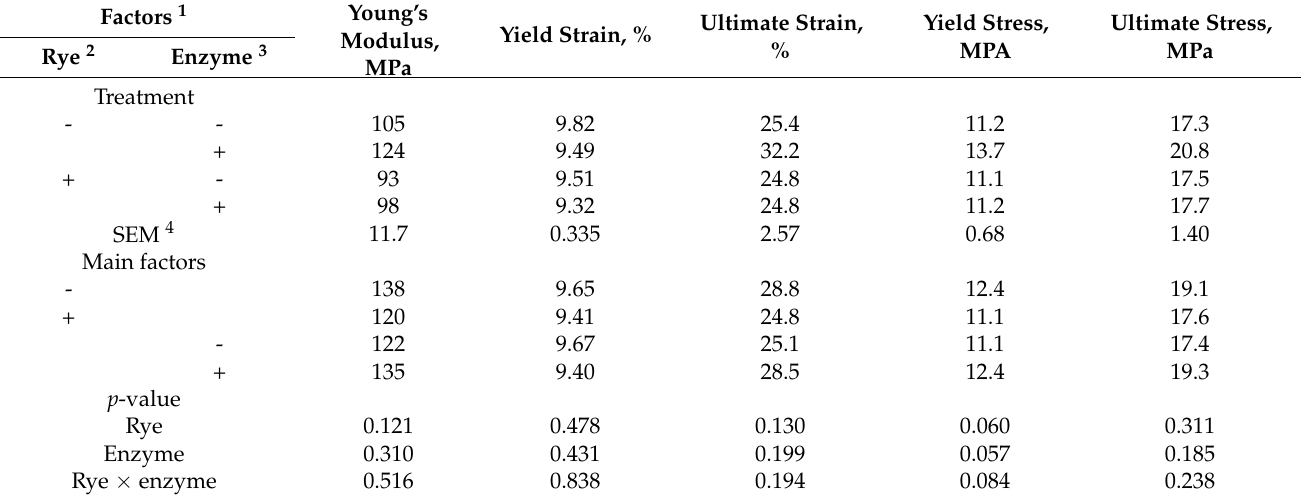
Table 9. Effect of dietary 25% rye inclusion and xylanase supplementation (200 mg/kg of feed) on hens’ tibial mechanical properties and geometrical properties at the end of the laying cycle–bone material